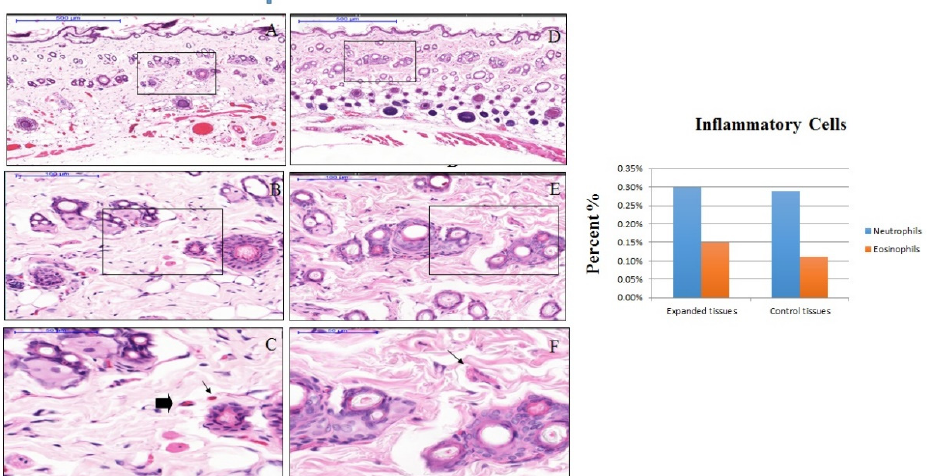
Figure 3. Hematoxylin and eosin (H&E) staining section of control ( D – F ) and expanded ( A – C ) rat skin. Representative serial magnifications of the dermis show isolated resident neutrophil (shown by black arrows in C ) and eosinophil (shown by black triangle in C ) in the connective tissue. The bar chart compares the percentage of inflammatory cells (neutrophils and eosinophils) in expanded and control tissues, with 0.30% neutrophils and 0.15% eosinophils in the expanded tissues, while 0.29% neutrophils and 0.11% eosinophils in control tissues.